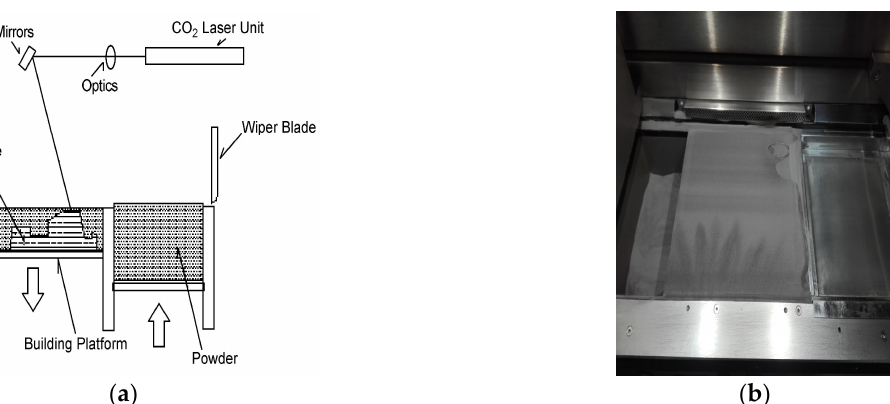
Figure 1. A schematic diagram [15] of the EOS Machine ( a ). The final sintering process in the production of samples on a DMLS 3D printer ( b ) .